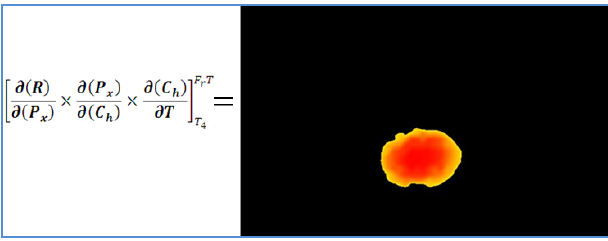
In the above figure, the consequent equation represents the thermal affected area at that certain temperature level. With the combination between 𝑔𝑔 �� � the partial deferential equation based area segmentation method and certain thermal chromatics value, : (255,148,4) shown in the thermographic image is Figure 18. Temperature affected area at the red alarm level